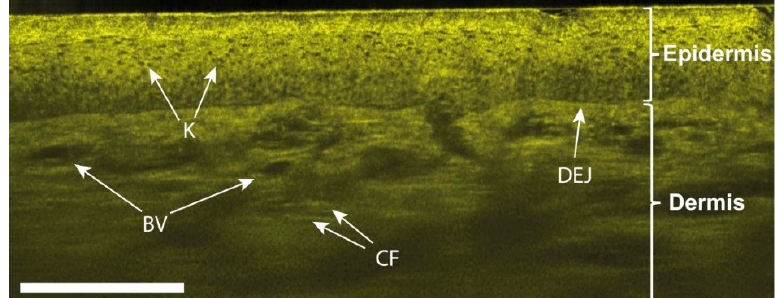
Figure 9. Reproduced with permission from Ref. [ 55] , an in vivo B-Scan image of human skin, with 1.3 (lateral) × 1.1 (axial) µm resolution, taken with a Mirau LF TD OCT. The features resolvable due to this resolution include (K) epidermal cells, (CF) dermis collagen fibres, (BV) blood vessels and (DEJ) dermoepidermal junction.